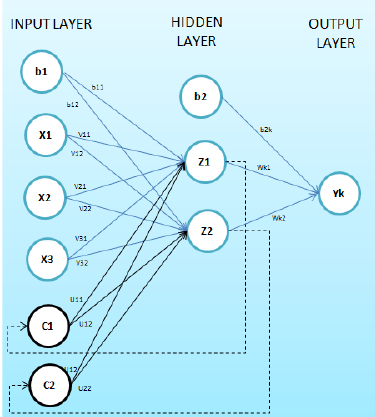
Fig. 1 ERNN network architecture